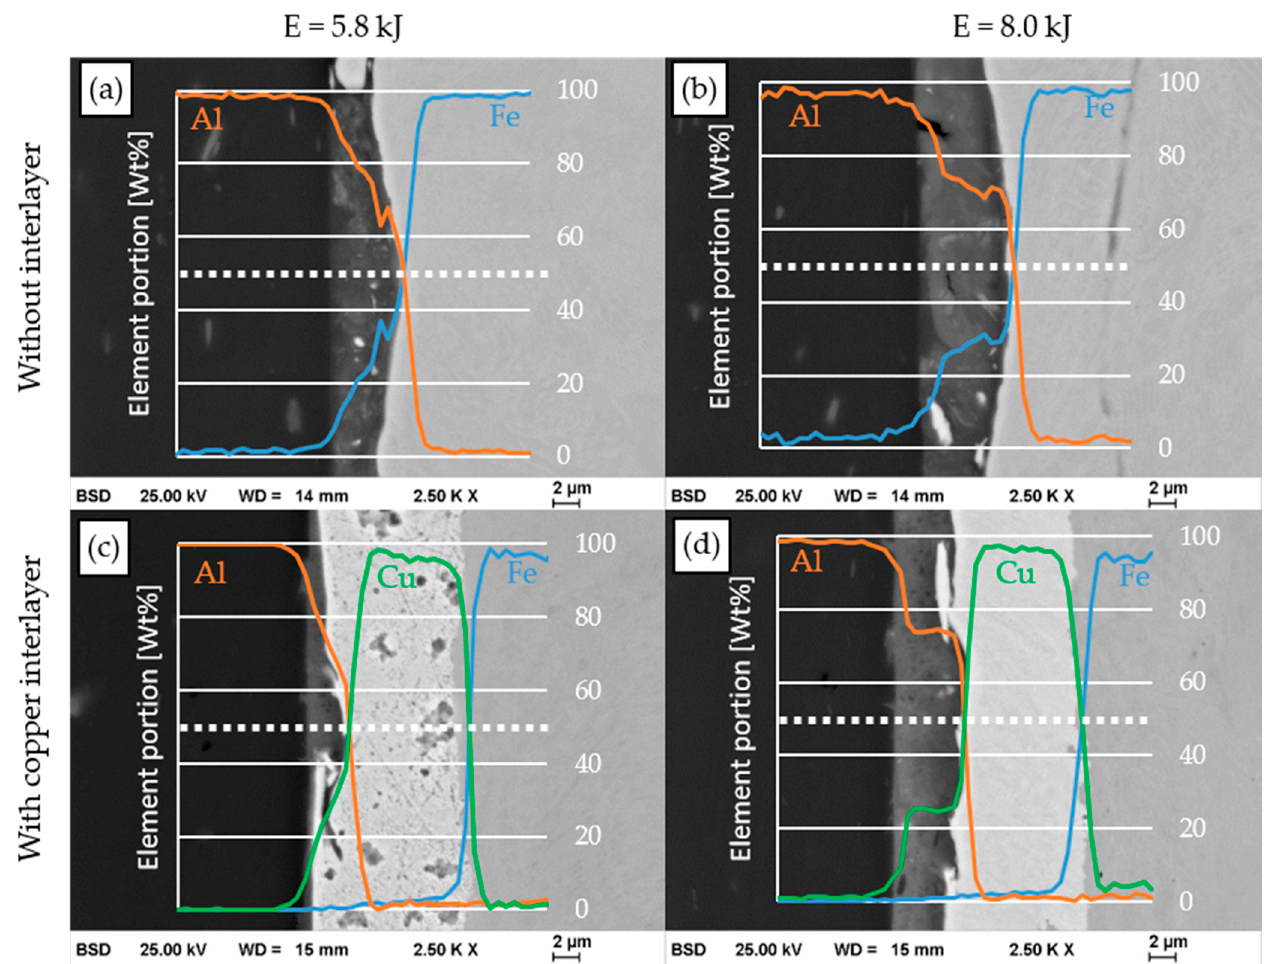
Figure 9. Comparison of EDS line scans perpendicular to the weld interface at the dotted lines at x 1 = 4 mm from samples ( a , b ) without and ( c , d ) with copper interlayer magnetic pulse welded at two different energy levels.